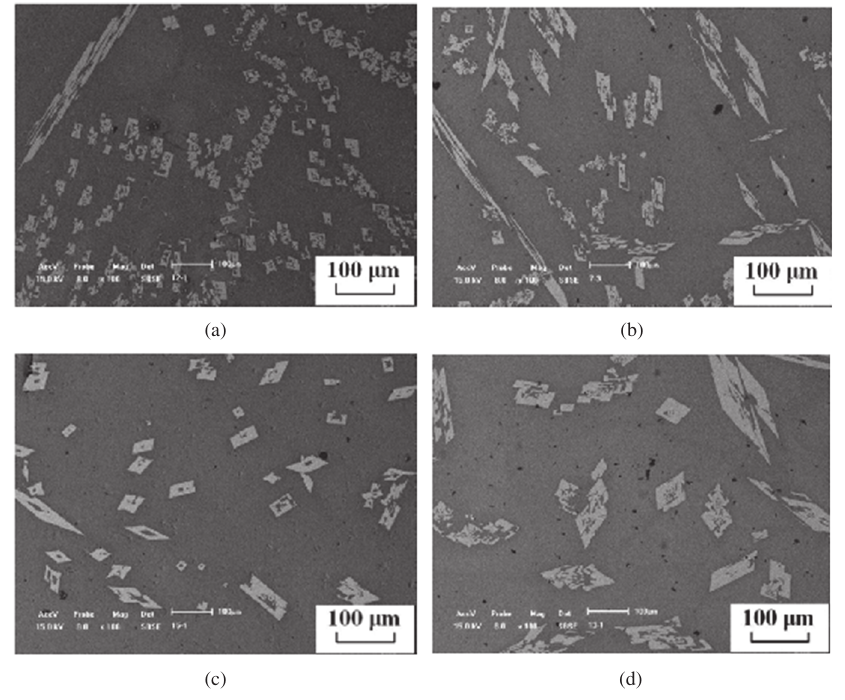
Figure 9: SEM images of the slowly cooled slag at different melting tempera- tures: (a) 1,703 K; (b) 1,713 K; (c) 1,723 K and (d) 1,733 K.